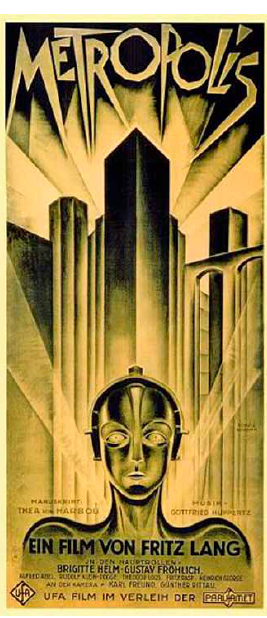
fig. 1. Metropolis original 1927 theatrical release